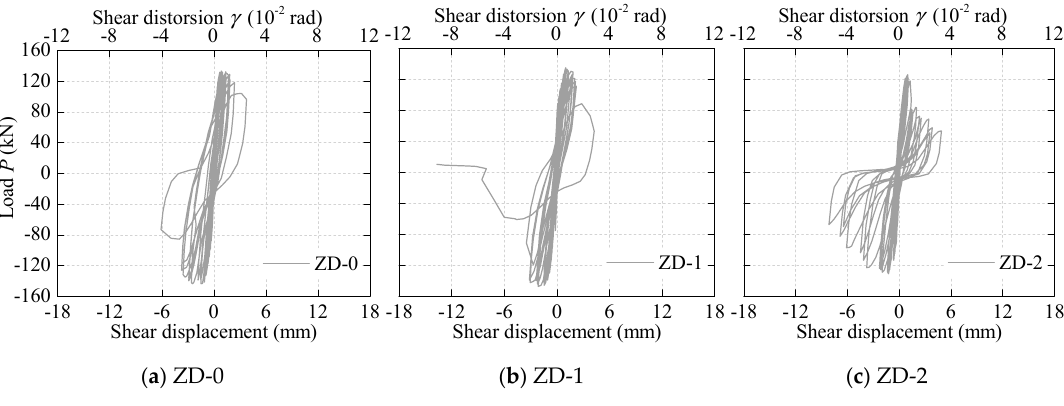
Figure 12. Measured lateral load versus shear distortion.